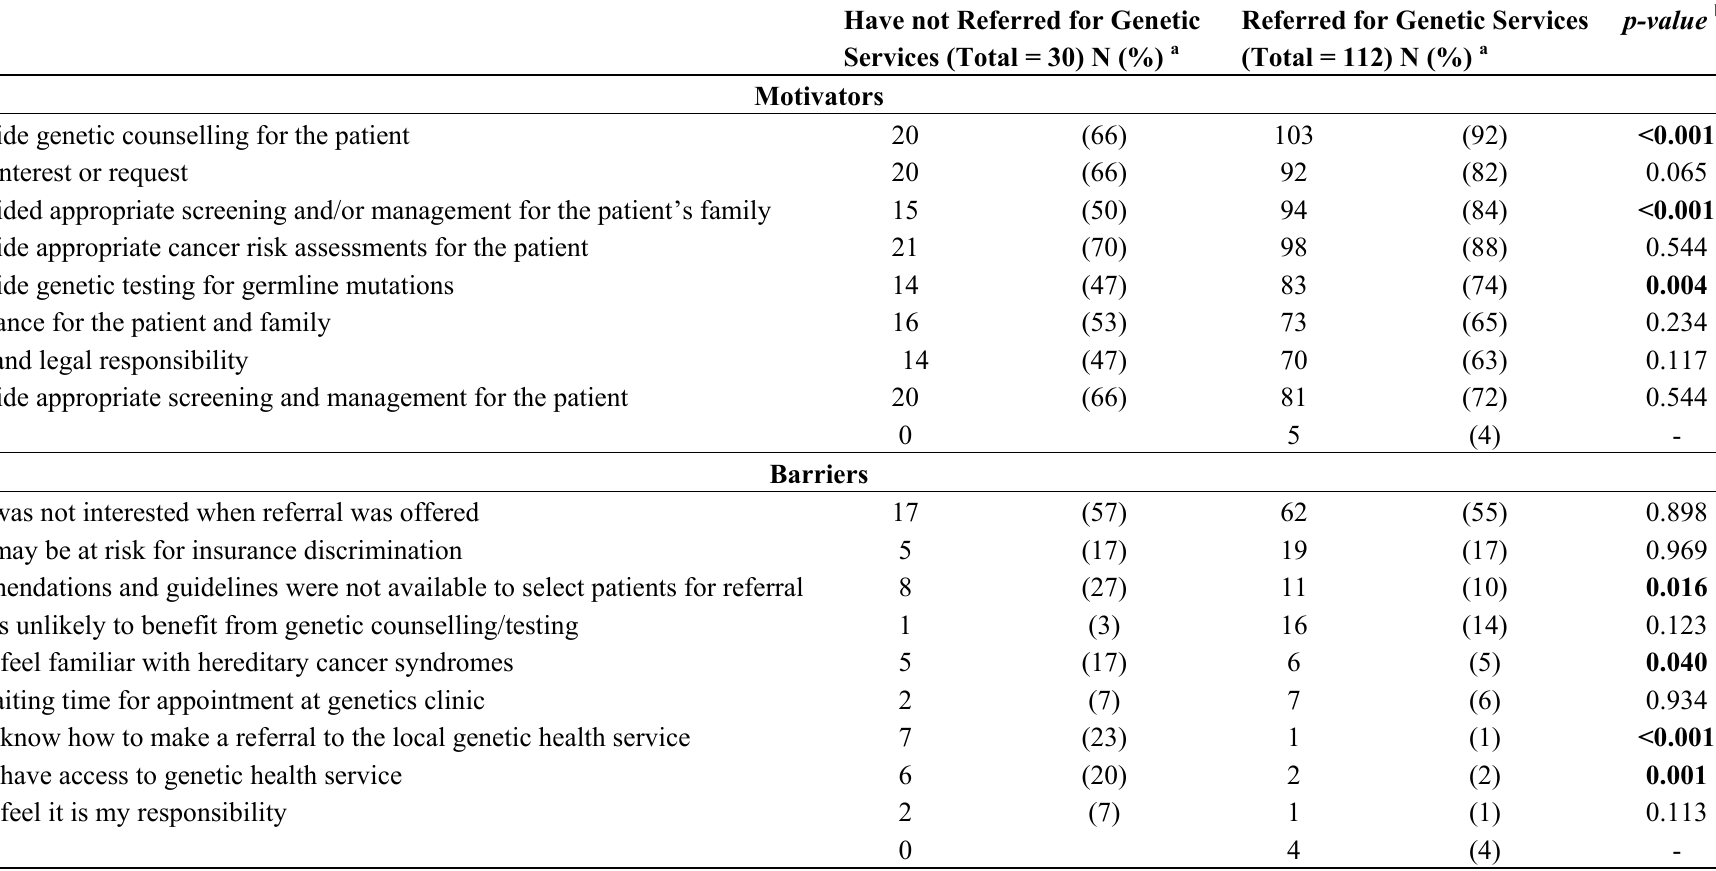
Table 3. Motivators and barriers of referral of patients suspected with Lynch syndrome for genetic services